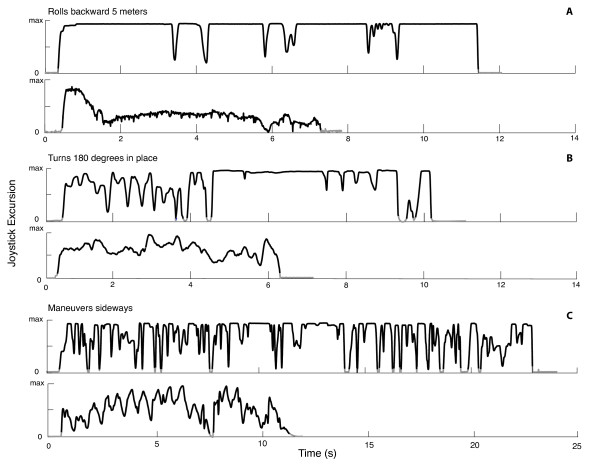
Temporal schematic of joystick excursions for novice and experts users during individual PW tasks. Biaxial joystick excursions for typical novice (top) and expert (bottom) users during A: Rolls Backward 5 m B: Turns 180° in Place and C: Maneuvers Sideways tasks. The black traces indicate when joystick excursion exceeded a resting threshold of 5%.